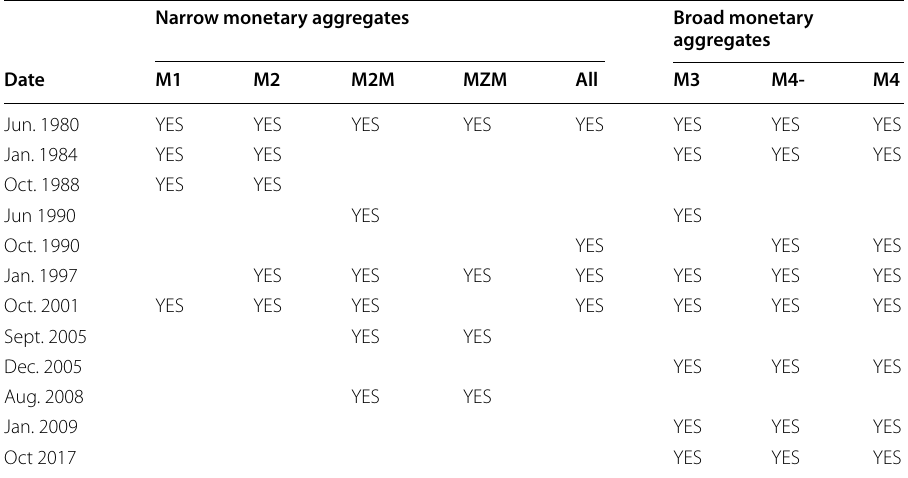
Table 6 Dates when the dynamics of the growth rates of Divisia monetary aggregates exhibit significant dynamical changes Narrow monetary